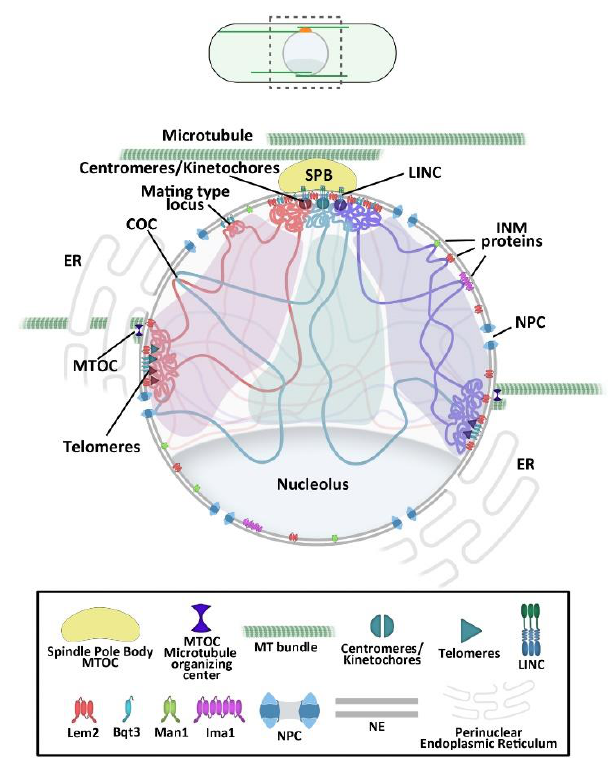
Figure 1. Schematic representation of the fission yeast nucleus. Schematic representation of a fission yeast cell (above). Magnification of the area marked by dashed lines (below). Global chromosome organization with centromeres attached underneath the spindle pole body (SPB) and telomeres and nucleolus distantly positioned. Chromatin is linked to the nuclear envelope (NE) by the interaction of different genomic elements with inner nuclear membrane (INM) proteins and linker of nucleoskeleton and cytoskeleton (LINC) complexes. Note that the interaction of Lem2 protein with chromatin might be indirect. The NE is continuous with the perinuclear endoplasmic reticulum. The SBP and other microtubule organizing centers (MTOCs) organize antiparallel bundles of microtubules (MTs)